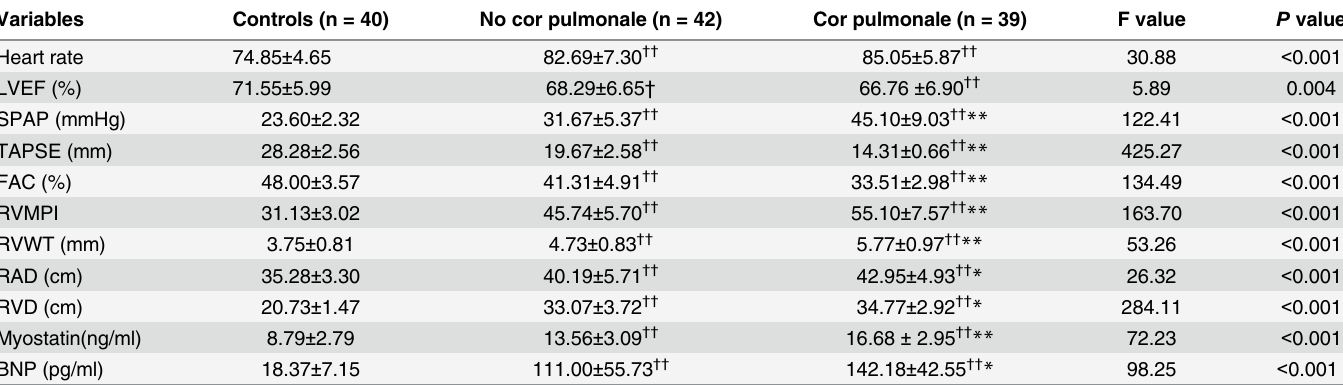
Table 2. Echocardiographic Data in Controls and Two Subgroups of COPD (Cor Pulmonale and No Cor Pulmonale) (Mean ± SD).